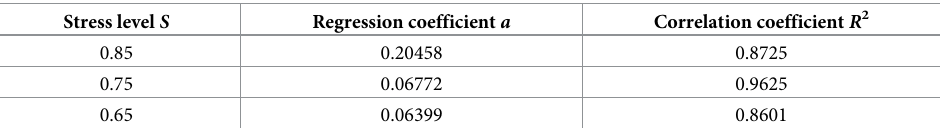
Table 12. Regression parameter